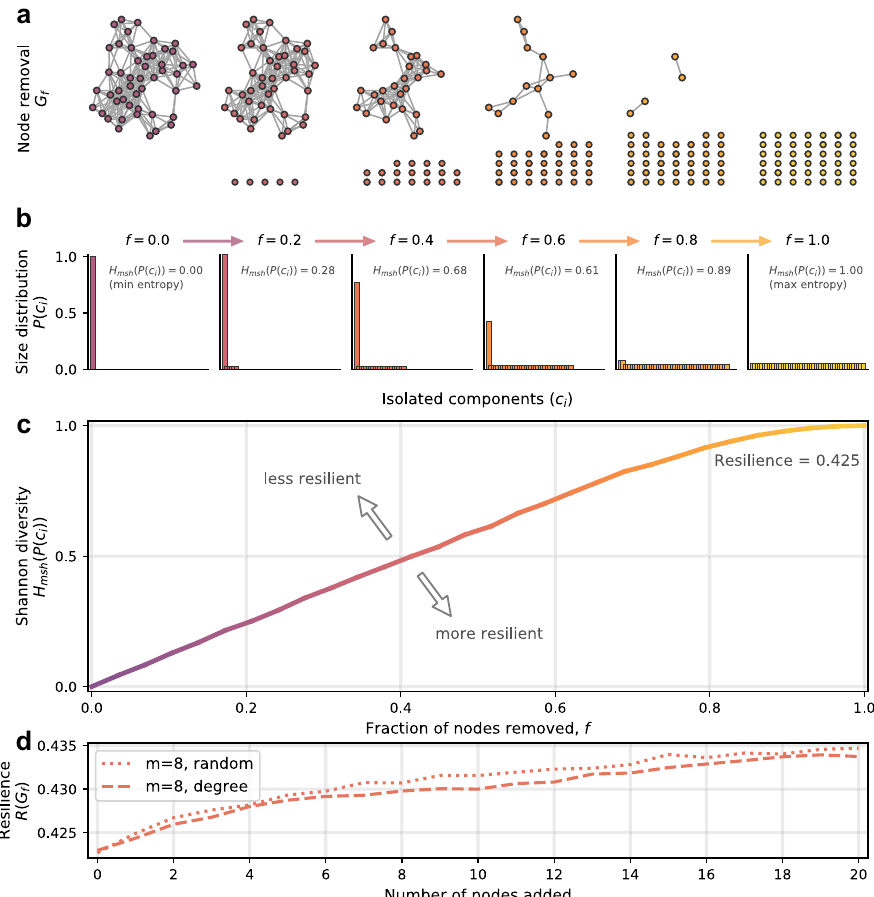
Fig. 1 Change in the Shannon diversity and network resilience. A visual intuition is provided to depict how network structure is associated with a particular resilience value. a Network resilience is calculated by iteratively isolating fractions of nodes in the network, f , eventually leaving N isolated nodes. b Following every iteration, the Shannon diversity of the component size distribution is calculated, in this case starting at f = 0 (one connected component), and increasing until every node is disconnected, f = 1. c Increasing the fraction of nodes that have been isolated creates a curve of increasing entropy values, which is used to compute the network resilience, as in Eq. (2). d An example of the prospective resilience of the network shown in ( a ). New nodes are iteratively added to the original network, with m links attached randomly or preferentially based on the degree of nodes in the